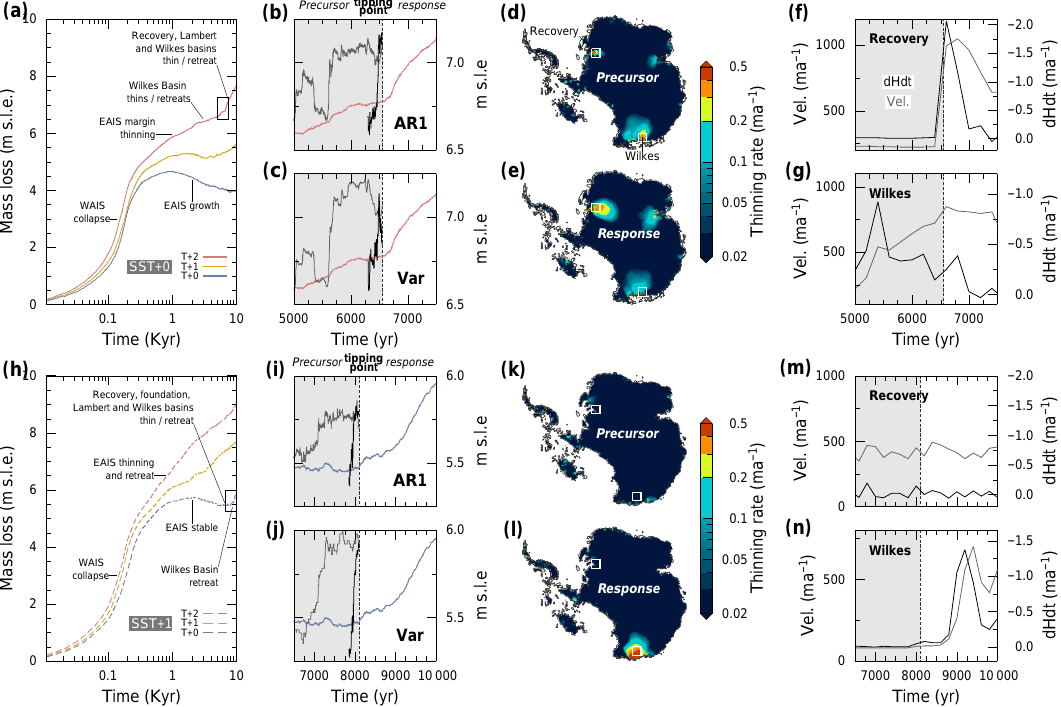
Figure 8. (a) Sea-level equivalent ice mass loss for ice-sheet simulations forced by regional climate model outputs allowing for 0–2 ◦ C air temperature bias. Inset box identifies region shown in (b, c) . Precursor signatures of tipping points: (b) increasing autocorrelation (AR1), and (c) increasing variance (Var). Grey lines show precursors over 1500-year sliding window, black lines show precursors during the 250-year sliding window immediately preceding the tipping point. Additional detail shown in Fig. 9. Mean annual thinning rate over precursor (d) and response (e) periods. (f, g) Thinning rate (dHdt) and surface velocity (Vel.) at locations in the Recovery and Wilkes subglacial basins (white boxes in d, e ). Note the lagged response of peak ice velocity compared to thinning maxima. Panels (h–n) as (a–g) but for scenarios with 1 ◦ C sea-surface temperature bias.